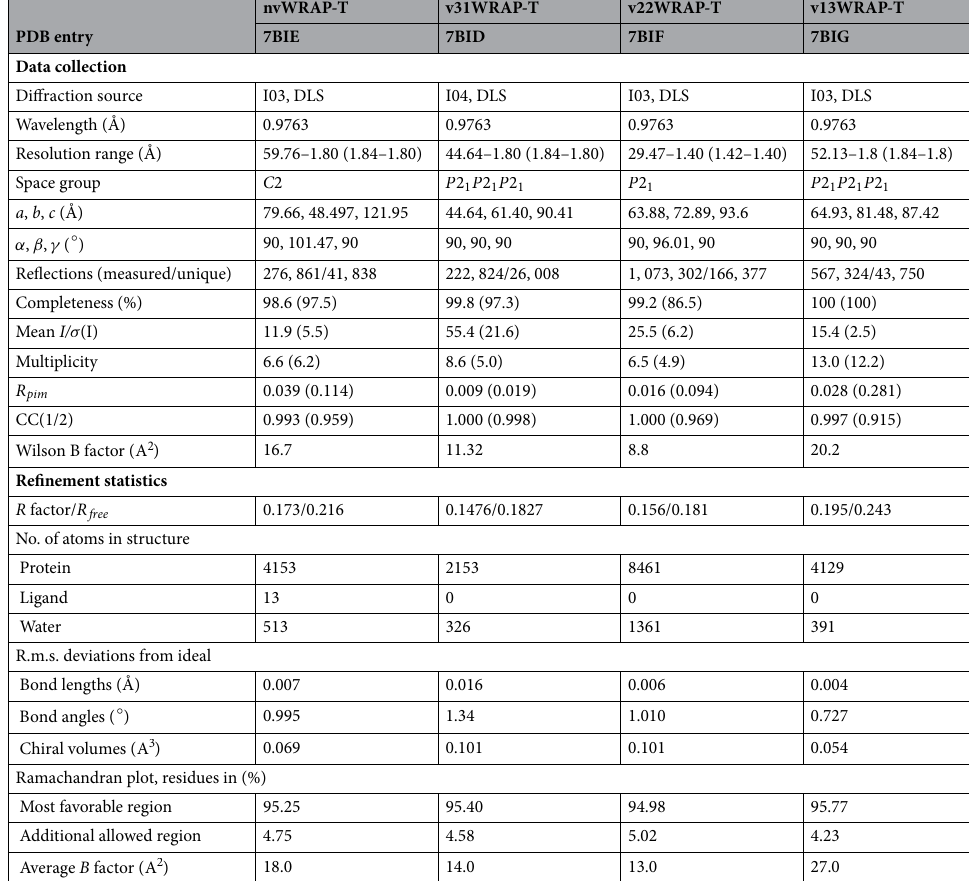
Table 1. Data collection and refinement statistics of X-ray structures. Values in parentheses are for the outer shell.